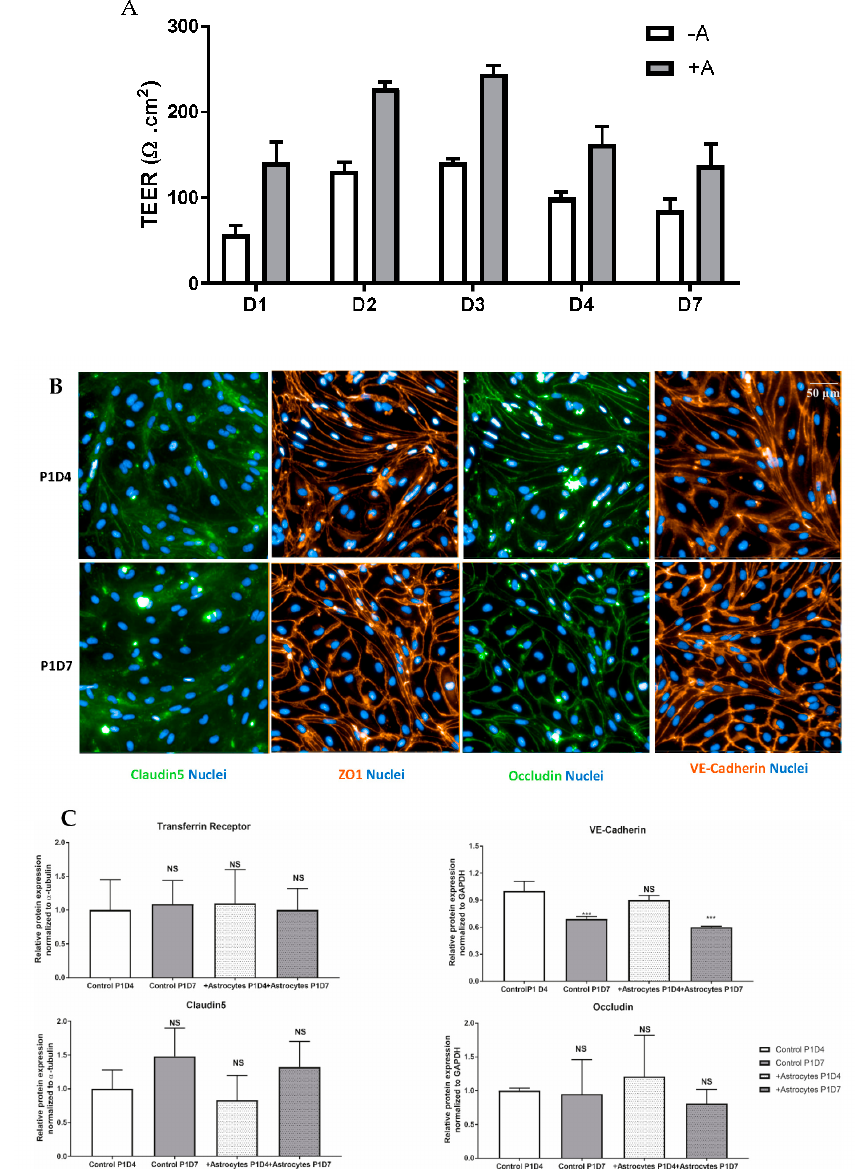
Figure 6. Profiling of essential proteins for maintenance of a BBB phenotype and transport properties in NHP-derived BECs. ( A ) TEER values registered across endothelial cells following several days in monoculture ( − A) or in co-culture with astrocytes ( + A). Data are presented as mean values from 3 independent experiments, each containing 4–8 filter inserts. ( B ) Immunofluorescence staining of several cell-cell junction proteins in BECs. Protein staining was obtained in the NHP-derived BBB model at P1 following either 4 or 7 days in vitro (P1D4 and P1D7, respectively) in the absence of primary rat astrocytes. ( C ) Relative protein expression of cell-cell junction and TFRC proteins in BECs. Relative protein levels were obtained in the NHP-derived BBB model at P1 following either 4 or 7 days in vitro (P1D4 and P1D7, respectively) in the absence or presence of primary rat astrocytes (control and + Astrocytes, respectively) and were assessed by western blotting (levels normalized to α -tubulin). Results are expressed and means of each group ± SD ( n = 3 independent experiments); p -values were obtained by One-way ANOVA with Dunnett’s multiple comparison test vs. Ctrl P1D4 groups, NS = p > 0.05, * = p < 0.05, ** = p < 0.01, *** = p < 0.001.